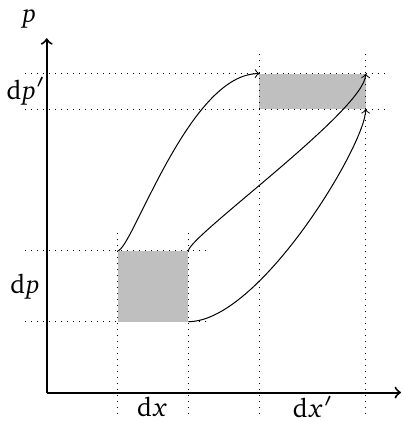
Figure 6: This figure depicts how the phase space volume occupied by particles within ( x , x + d x ) and ( p , p + d p ) changes in a time step d τ to ( x (cid:48) , x (cid:48) + d x (cid:48) ) and ( p (cid:48) , p (cid:48) + d p (cid:48) ) . The particle number in both elements is the